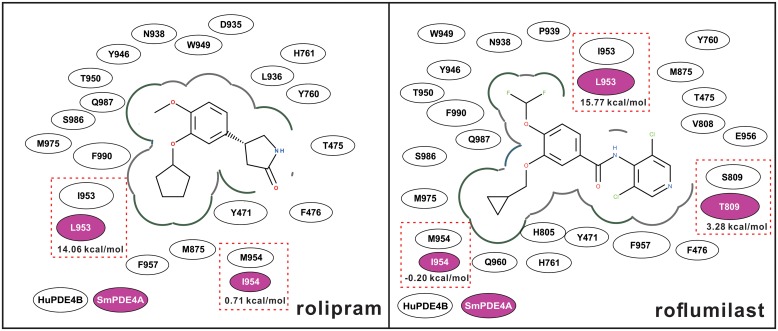
2D interaction diagram of rolipram and roflumilast with huPDE4B and SmPDE4A.Molecular models of each enzyme in complex with rolipram and roflumilast were built using ICM-pro and huPDE4B1 as a template (PDB ID: 4X0F) [79]. The amino acid residues in the huPDE4B1 and SmPDE4 binding sites that interact directly with the ligands are shown as ovals. Those that distinguish the schistosome ortholog are shown in magenta and the consequent changes in binding free energies are indicated underneath. The residue numbers are consistent with the alignment presented in Fig 2.